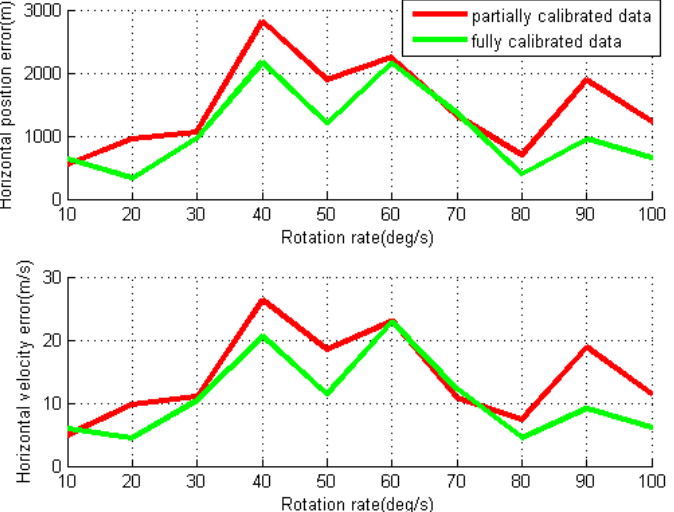
Figure 8. Root mean square (RMS) values of horizontal position and velocity errors for rotary INS with different IMU rotation rates using MTi-G.